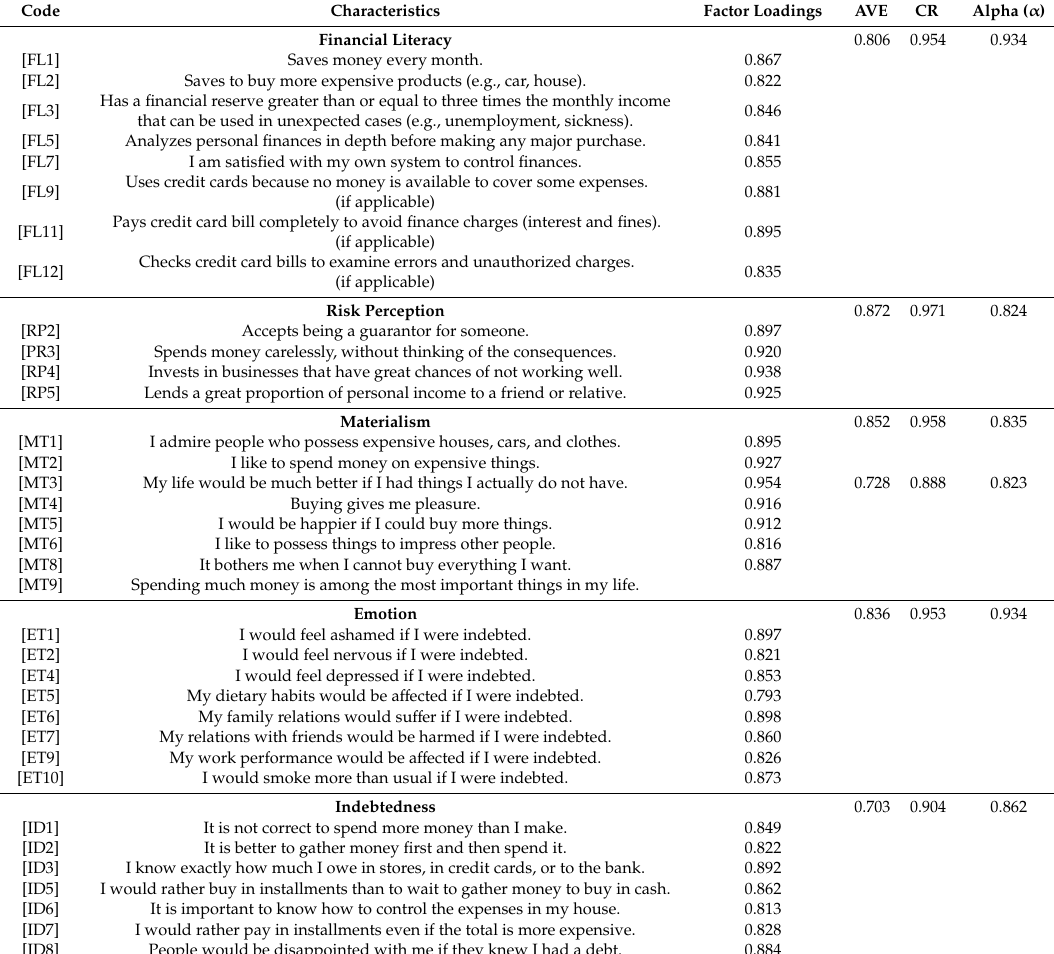
Table 2. Convergent validity.